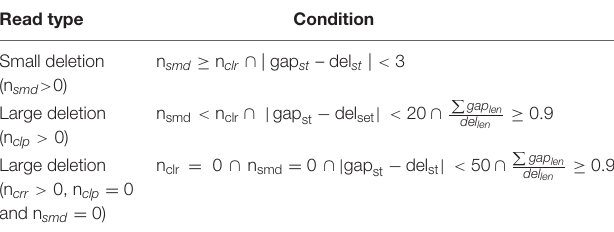
TABLE 2 | Criteria for homozygous deletion identification. Read